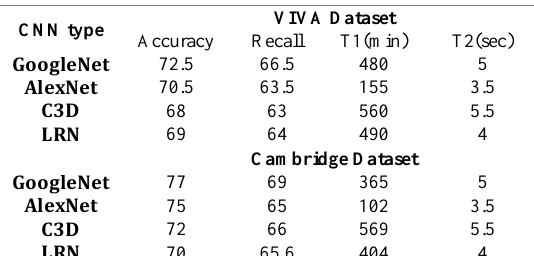
Table 7. Comparison between 2D model and 3D model results. t1 and t2 represent the training and testing